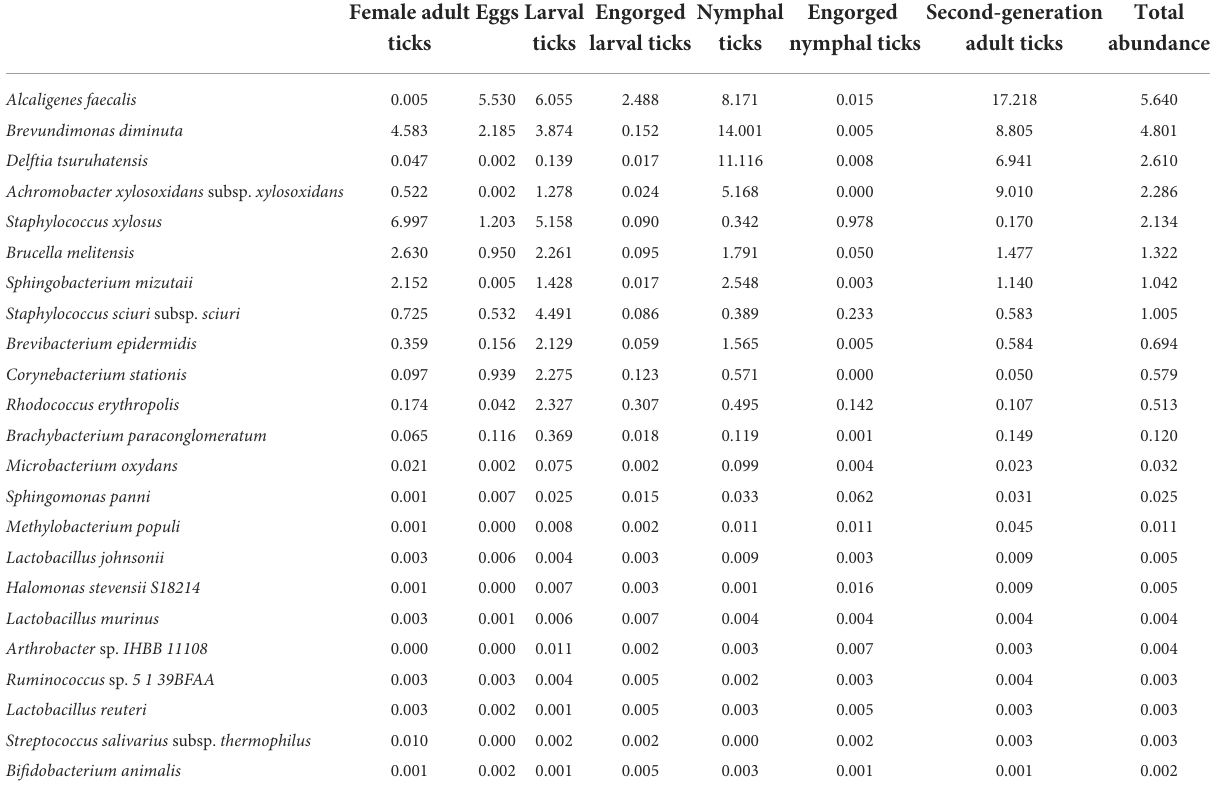
TABLE 6 The relative abundance of 23 bacterial species in the 7 samples. Bacterial species Relative abundance (%) Female adult Eggs Larval Engorged Nymphal Engorged Second-generation Total ticks ticks larval ticks ticks nymphal ticks adult ticks